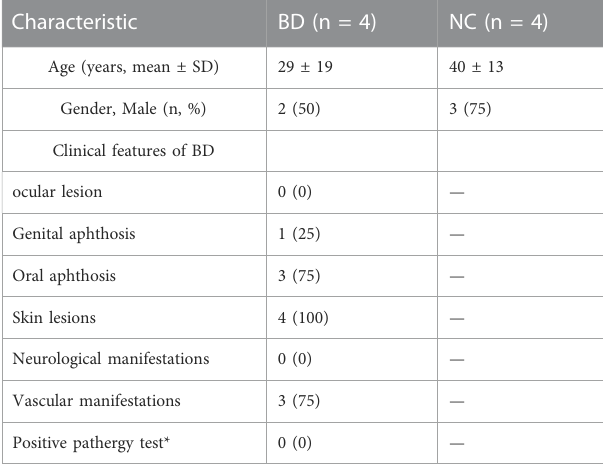
TABLE 1 Demographics and Clinical characteristics of BD patients and